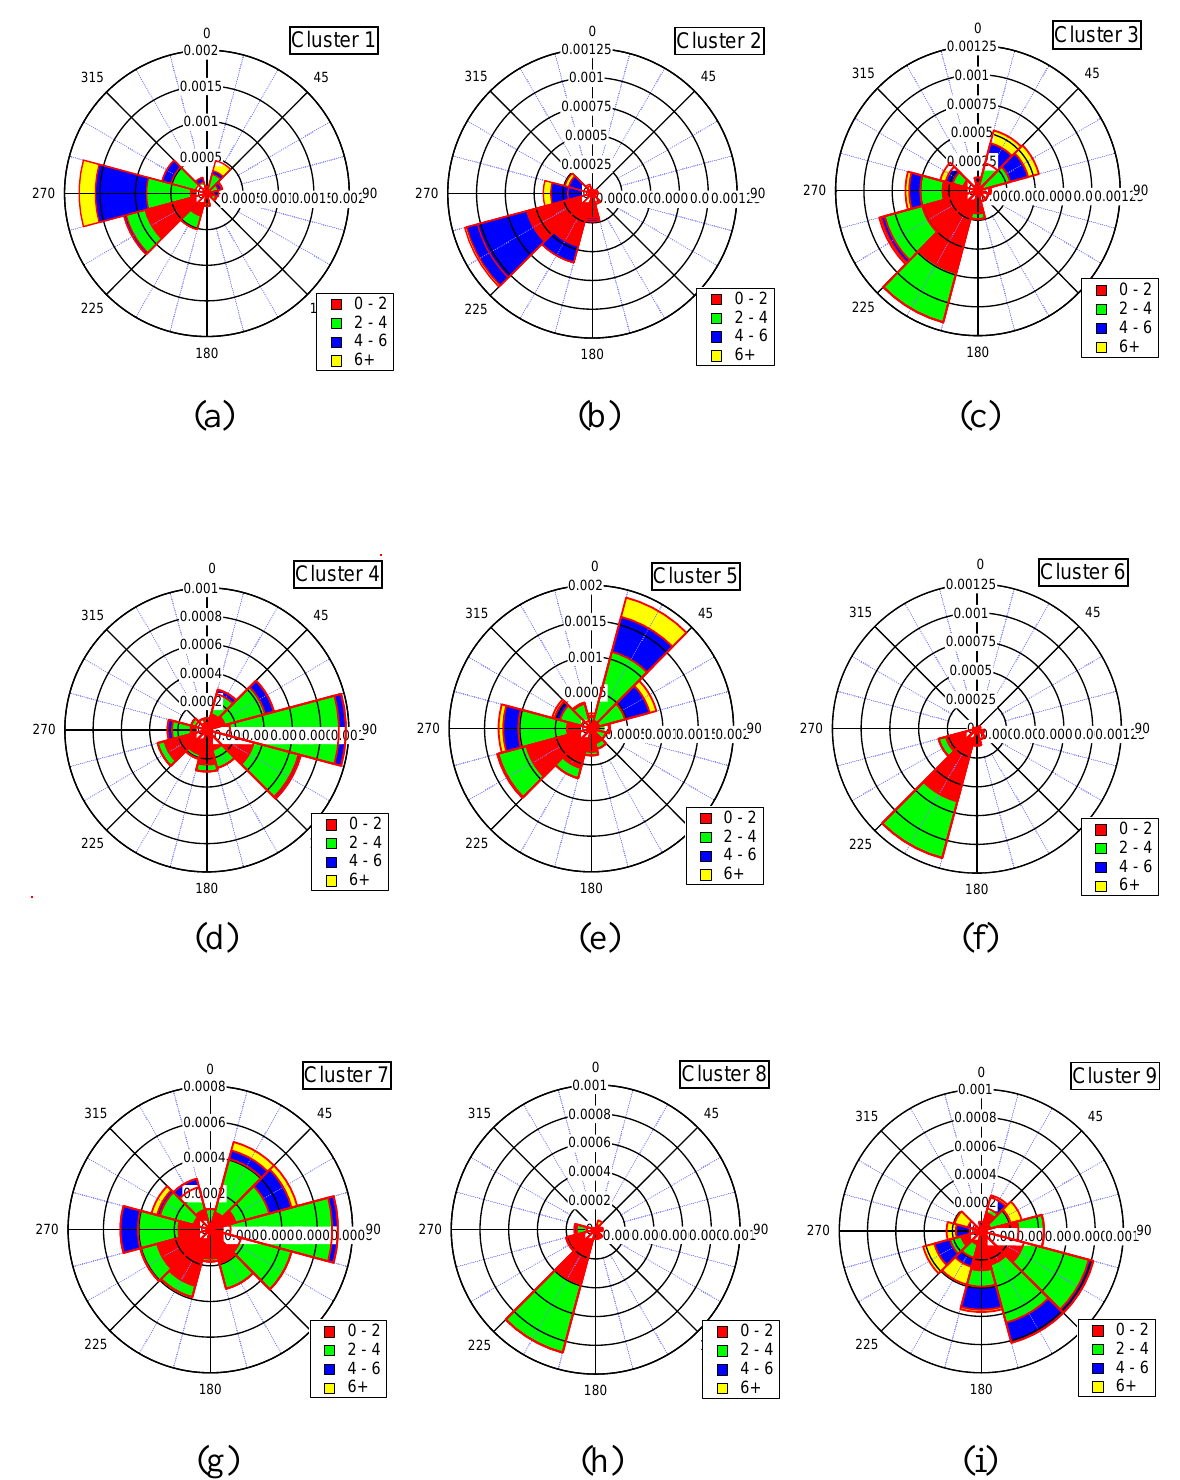
Fig. 4. Wind roses ( ◦ ) associated with each DMPS cluster. Wind data from the meteorological observatory was used for the calculation. Colour plot represents the wind speed (ms − 1